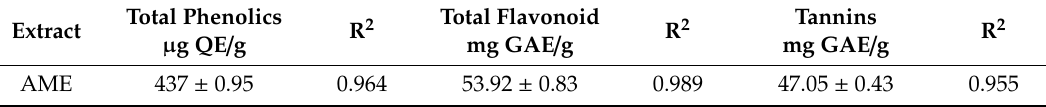
Table 1. Total phenolics content, total flavonoid content and tannins content of AME extract. Total Phenolics Extract